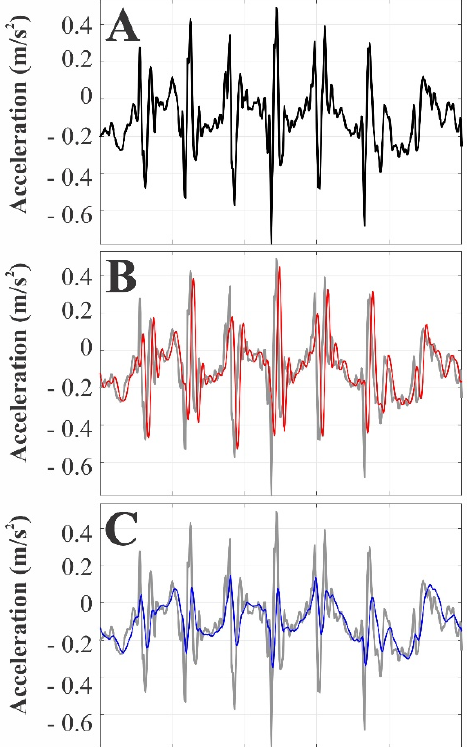
Figure 1. Timed up-and-go test inertial recordings: ( A ) raw data (without filters), ( B ) data with the Butterworth filtering process, and ( C ) data with the Kalman filtering process.